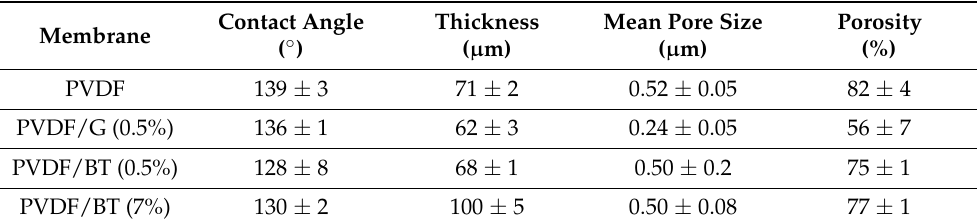
Table 2. Morphological parameters estimated for tailored pristine and PVDF/2D materials membranes.